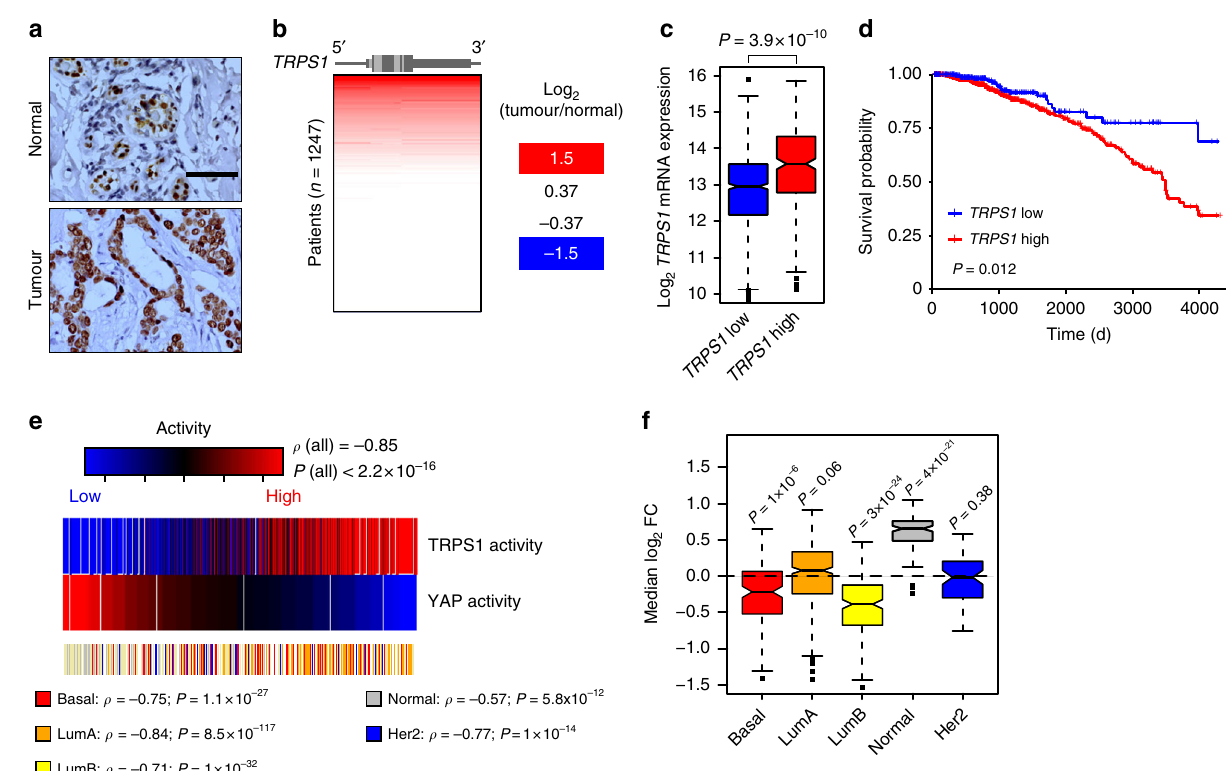
Fig. 7 TRPS1 is overexpressed in breast cancer and is predictive for survival. a Immunohistochemical staining for TRPS1 on tissue sections from human breast cancer patients. Scale bar = 50 μ m. b TRPS1 gene ampli fi cation level in tumour vs. normal breast tissue from breast cancer patients of the TCGA data set. c Box plot showing TRPS1 mRNA levels in patients strati fi ed according to the level of ampli fi cation of the TRPS1 locus. Median: black line; boxes: data points between the fi rst and third quartiles; whiskers: up to 1.5 × interquartile range; points: outliers. Wilcox-test, two-sided. d Kaplan – Meier plot for the survival probability of breast cancer patients that were strati fi ed based on their TRPS1 ampli fi cation status. TRPS1 high: patients with TRPS1 ampli fi cation status above the third quartile compared to TRPS1 low (remaining patients). Chi-square test. e Analysis of TRPS1 and YAP activity in breast cancer patients (see Methods). The correlation between TRPS1 and YAP activities is given for all patients (all) and for the given breast cancer subtypes. The correlation coef fi cients ( ρ ) and the corresponding P -values were determined by a Spearman rank correlation test. f Box plots showing the expression of genes repressed by TRPS1 in different breast cancer subtypes. Median: black line; boxes: data points between the fi rst and third quartiles; whiskers: up to 1.5 × interquartile range; points: outliers. Wilcox-test,